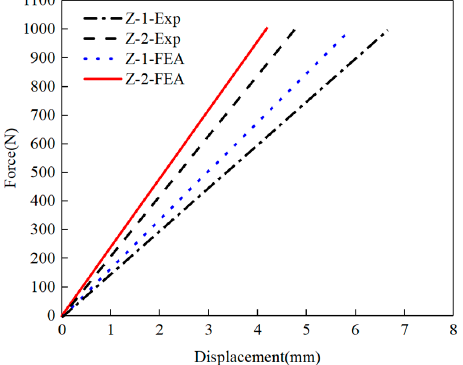
Figure 6. Load and displacement curve for bending stiffness.